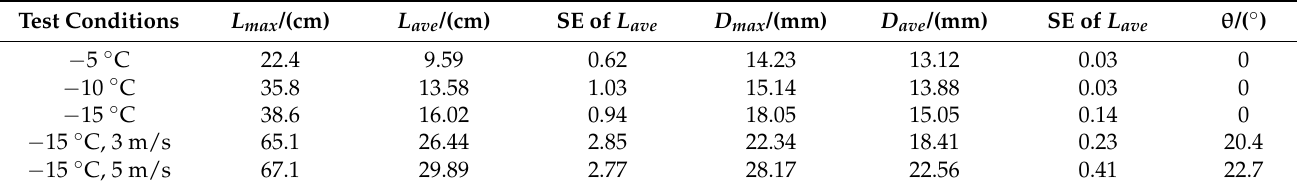
Table 3. The size of the icicle and ice layer under different ambient